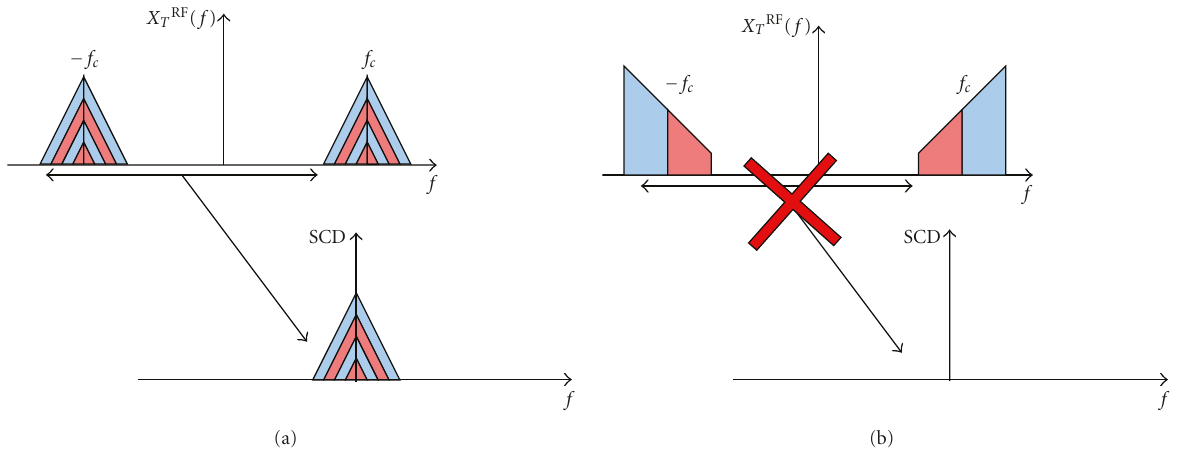
Figure 2: RF signal frequency spectrum (top) and SCD at twice the carrier frequency (bottom). The SCD is measured by the correlation between two frequency bins centered on f − α/ 2 and f + α/ 2 where α is the carrier frequency. The doubled-carrier frequency feature exists for RF PAM signals as the baseband frequency spectrum exhibits a correlation between negative and positive frequencies. In the absence of any filtering, this correlation produces a symmetric frequency spectrum (left part). The doubled-carrier frequency feature vanishes for RF QAM signals as the baseband frequency spectrum is uncorrelated (right